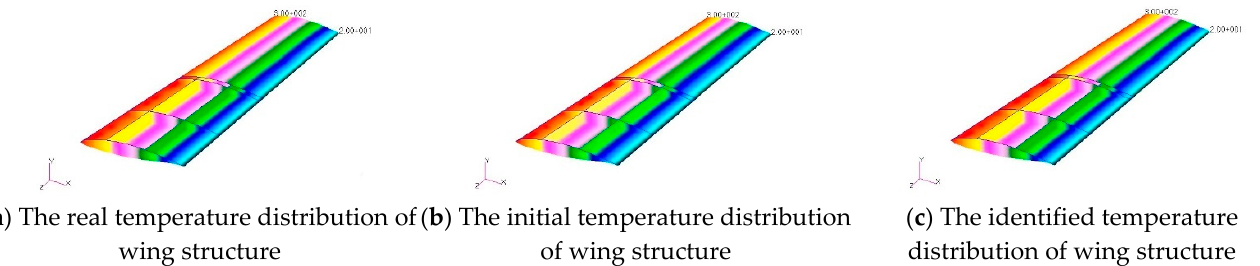
Figure 8. The comparison of real temperature distribution, initial temperature distribution and updated temperature dis ‐ tribution.